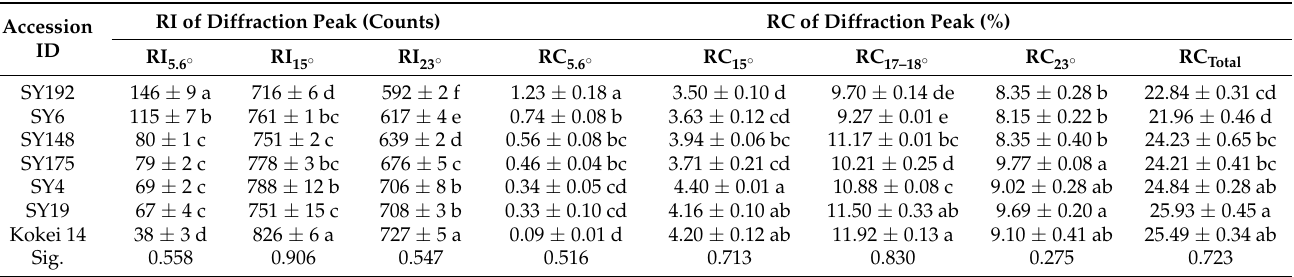
Figure 1. XRD patterns of C-type starches from different sweet potato varieties. Table 1. Relative intensities and crystallinities of diffraction peaks in XRD patterns of C-type starches.